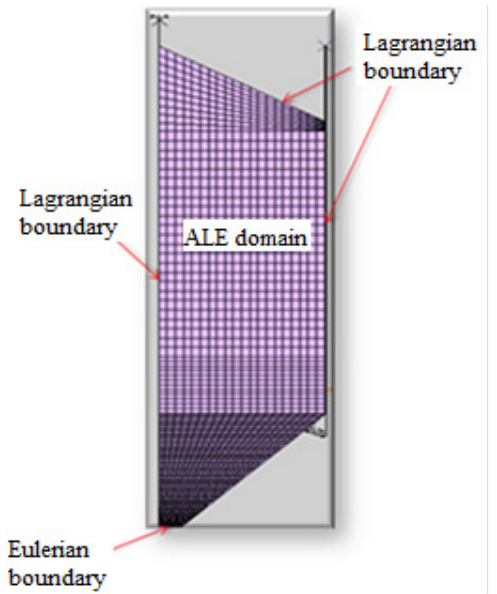
Figure 15 : Definition of ALE field on the numerical model (current